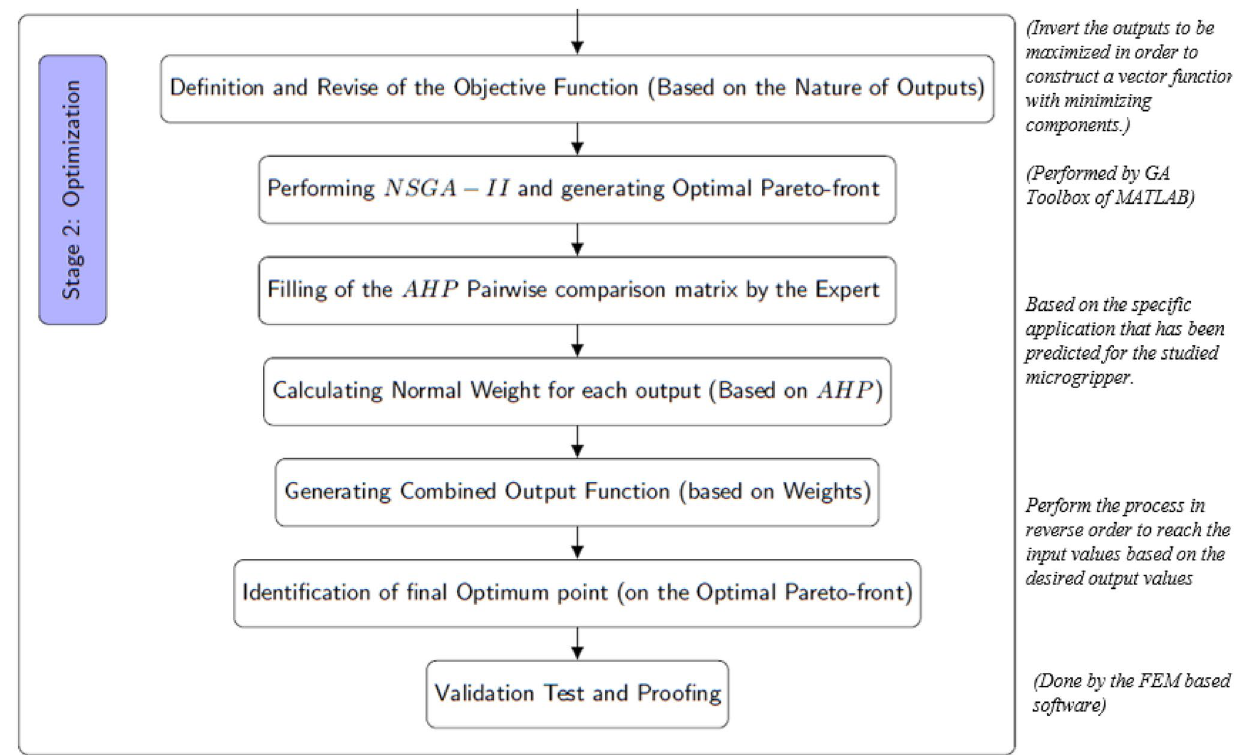
Fig. 6 Proposed optimization algorithm (stage2: